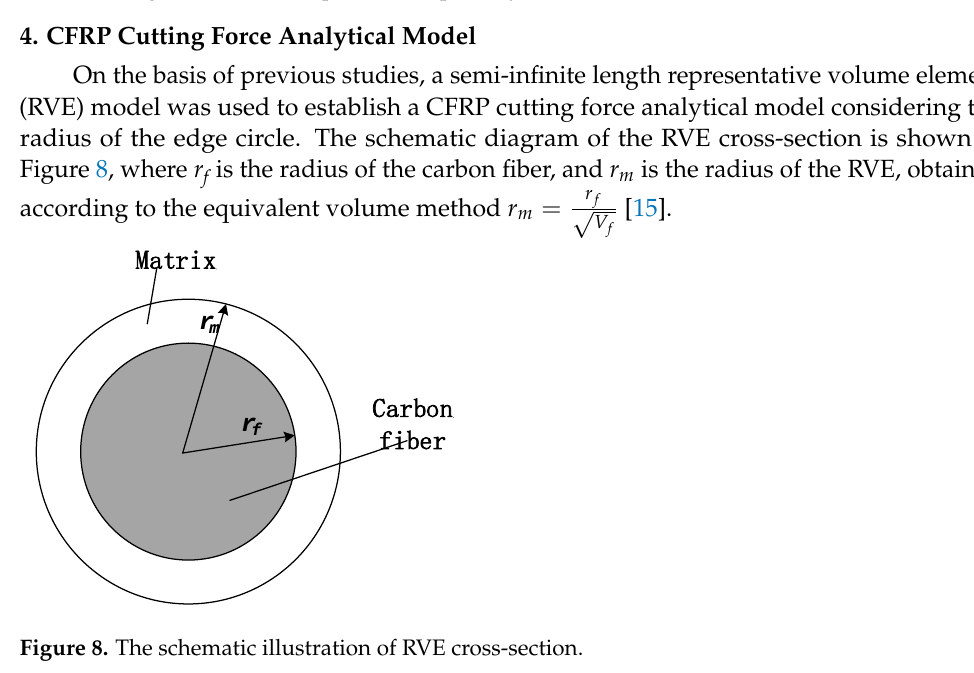
Figure 7. Single-fiber removal process: ( a ) primary fracture of fiber; ( b ) residual fiber removal.